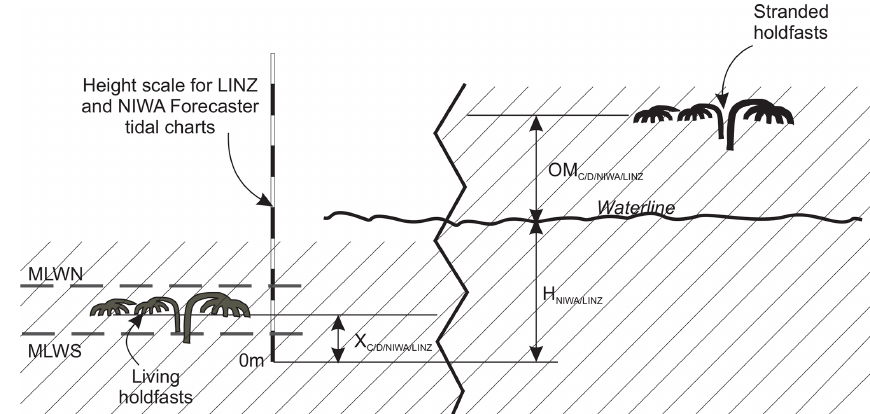
Figure 4. Schematic diagram illustrating the uplift and stranding of holdfasts used to calculate the offset of holdfasts ( X NIWA / LINZ ) from mean low-water spring (MLWS) independent from tide-gauge data. MLWN: mean low-water neap. Here MLWS is determined from LINZ and NIWA predictive charts, and the position of holdfasts with respect to MLWS and MLWN is determined from local knowledge of kelp distribution (Sharyn Goldstien, personal communication,